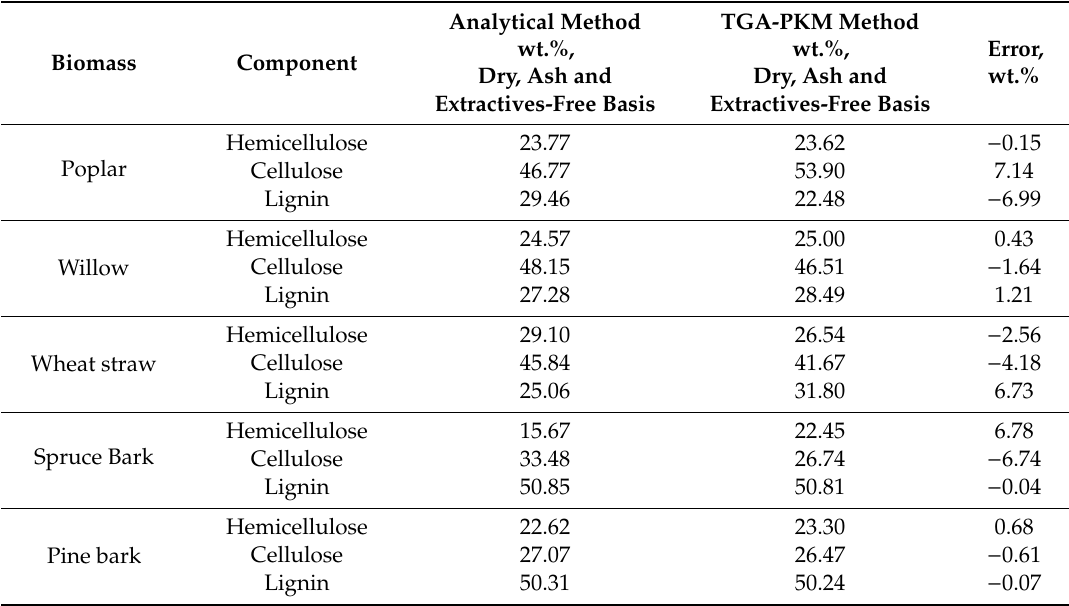
Table 9. Comparison between the analytical and thermogravimetric analysis-pseudocomponent kinetic model (TGA-PKM) results.